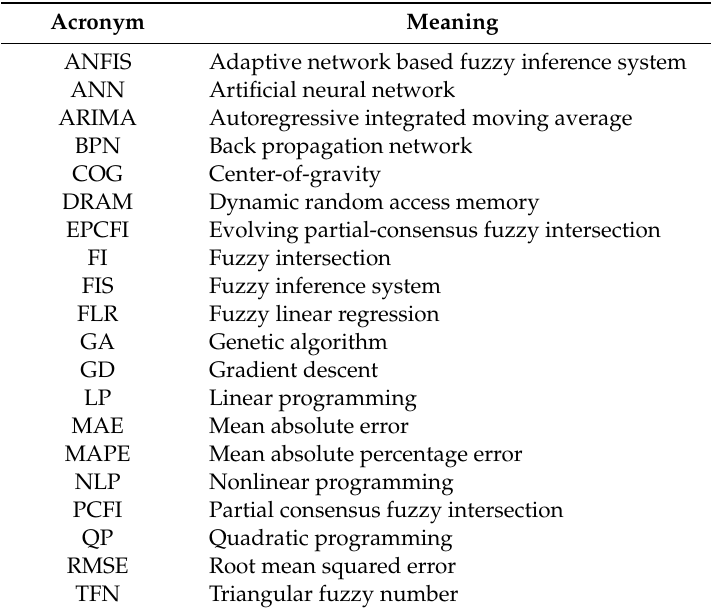
Table 2. Abbreviations used in this